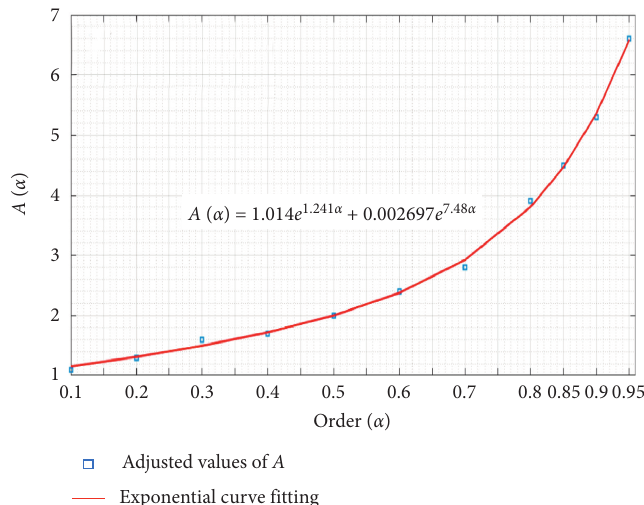
Figure 5: Approximation of A as an exponential function of α